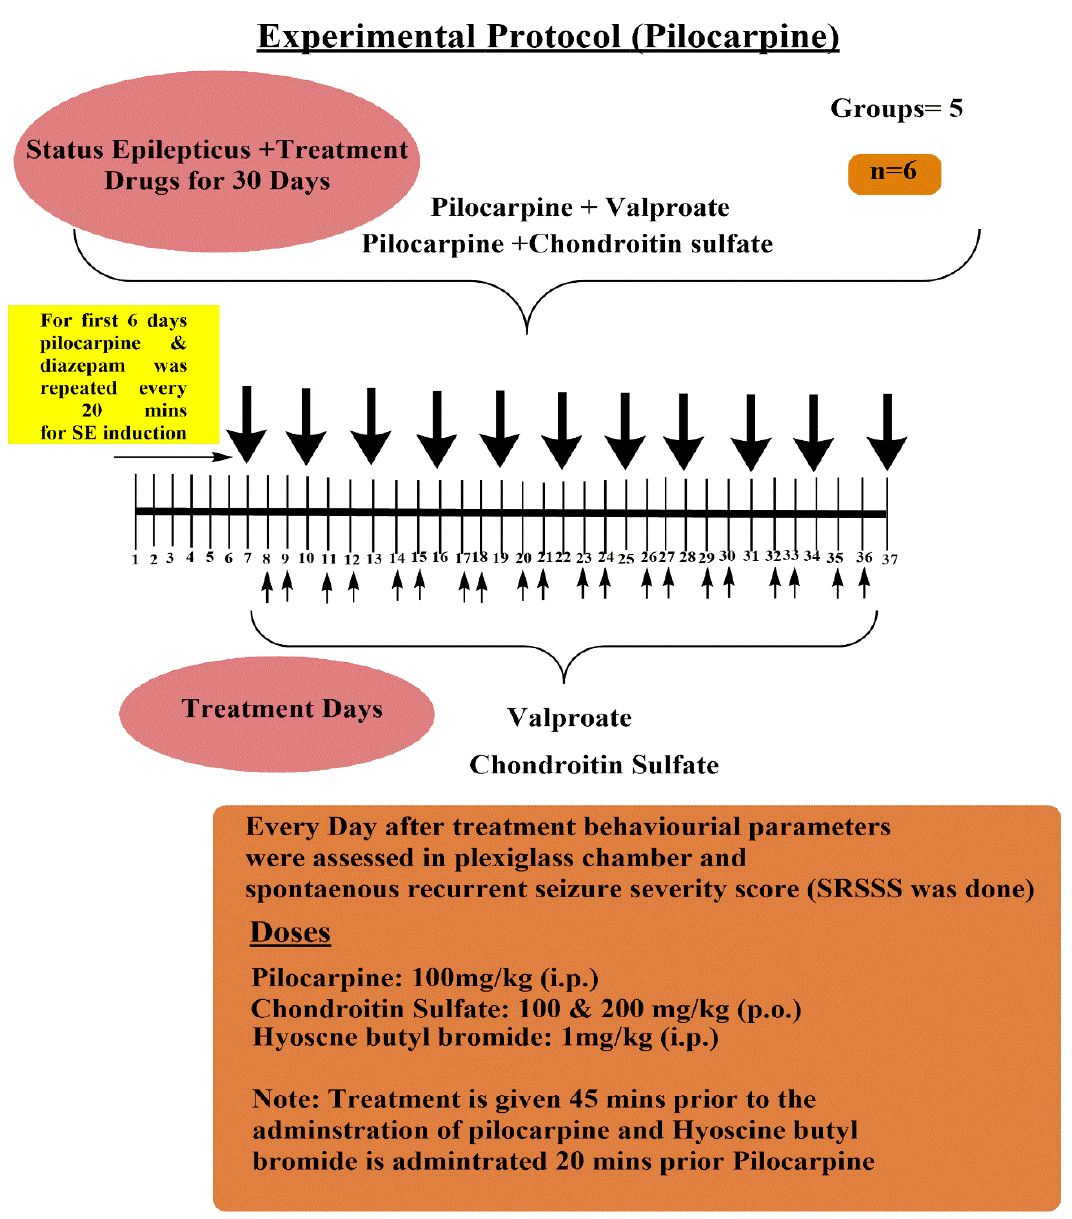
Figure 2. Experimental protocol for pilocarpine-induced spontaneous recurrent seizure severity score assessment proto- col.